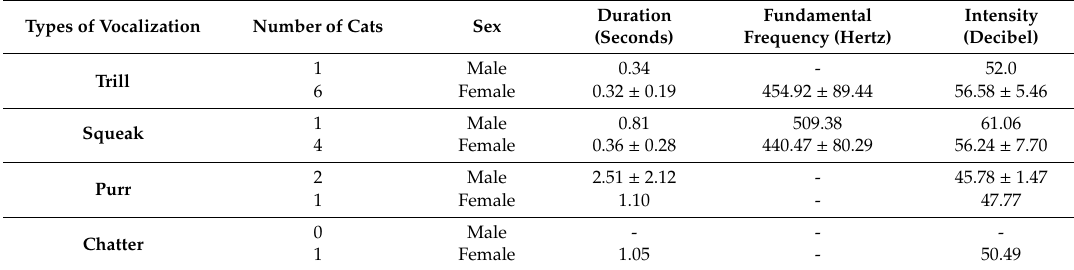
Table 1. Average and standard deviation for duration, fundamental frequency (f0) and intensity of the di ff erent types of vocalizations other than meowing (VOM) observed during the pleasant situation (PS) by sex of the animal, according to the analyses of 74 cats facing positive and aversive situations; only cats in the positive situations expressed